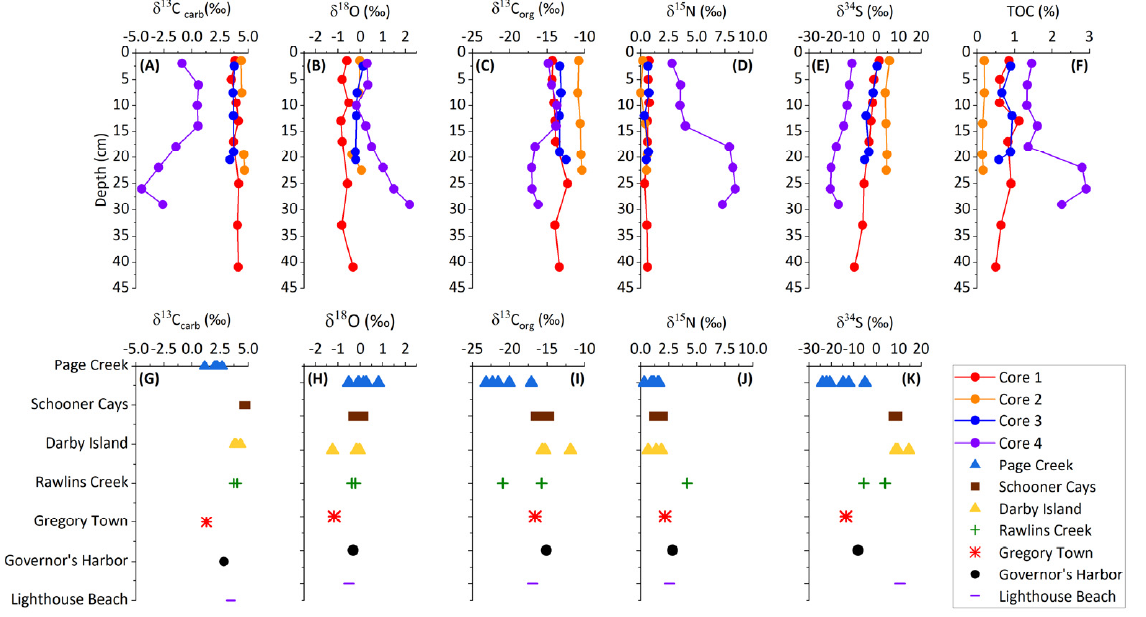
Figure 2. Light stable isotope and TOC core profiles for sediment cores and isotopic data for sediment grab samples. ( A – F ) are depth profiles of the four different cores and ( G – K ) are individual grab samples from different locations.